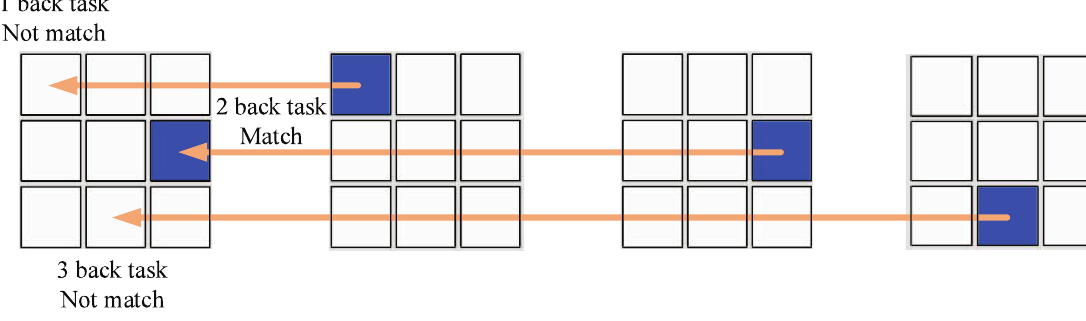
Figure 1. A sequence of position stimuli in 1-, 2-, 3-back tasks.